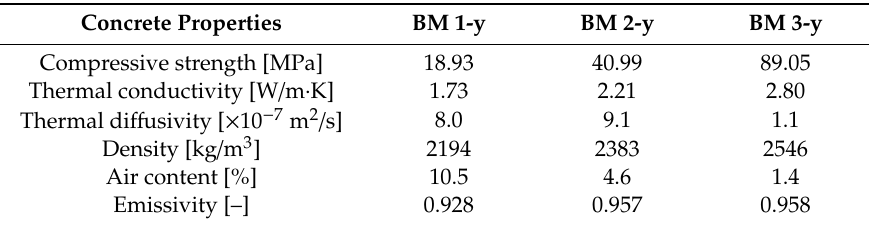
Table 1. Physical and mechanical properties of three concrete types used.